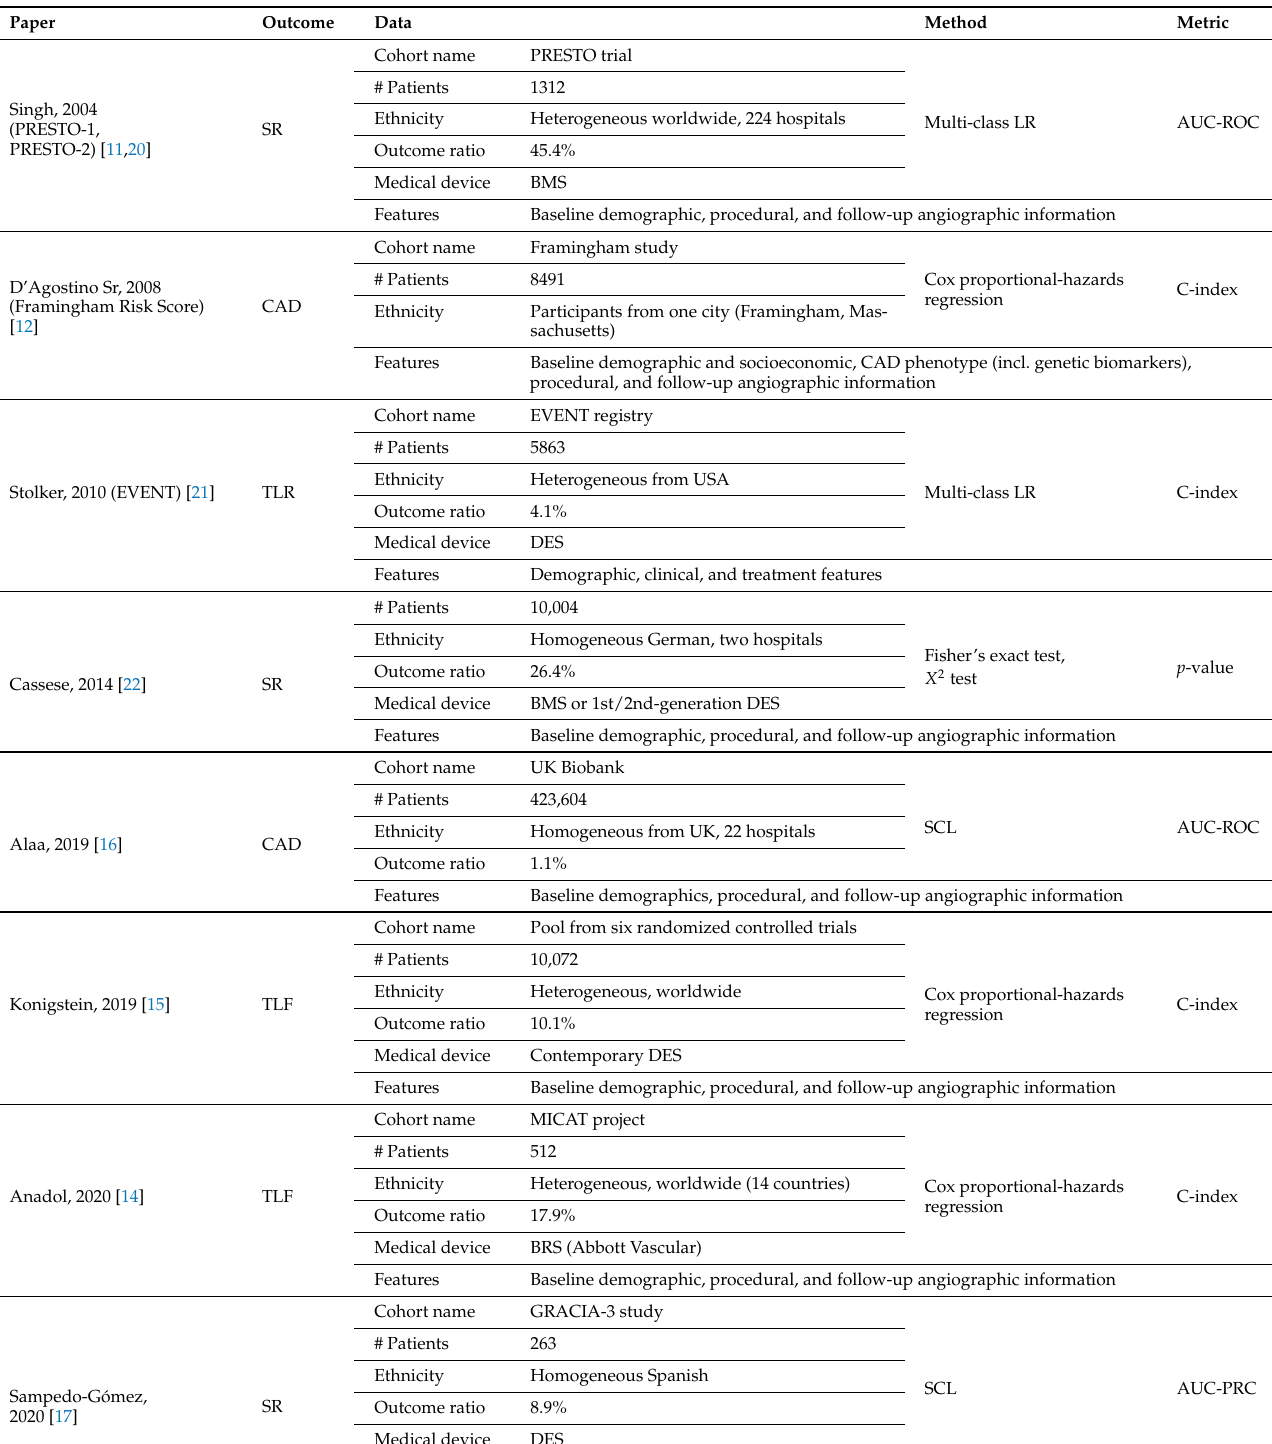
Table 1. Summary of literature review. CAD = coronary artery disease, CVD = cardiovascular disease, SR = stent restenosis, TLR = target lesion revascularization, SCL = supervised